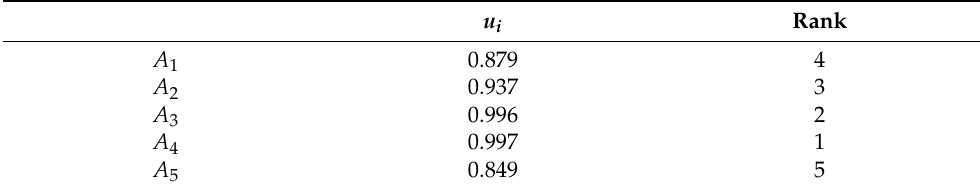
Table 20. The overall utilities of considered